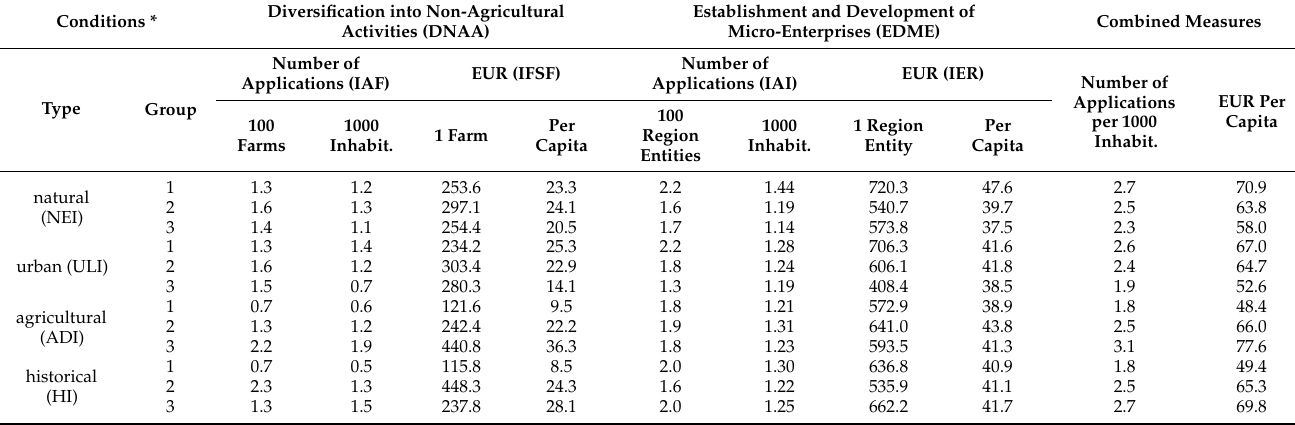
Table 1. The impact of the conditions on the diversification of EU funds absorption